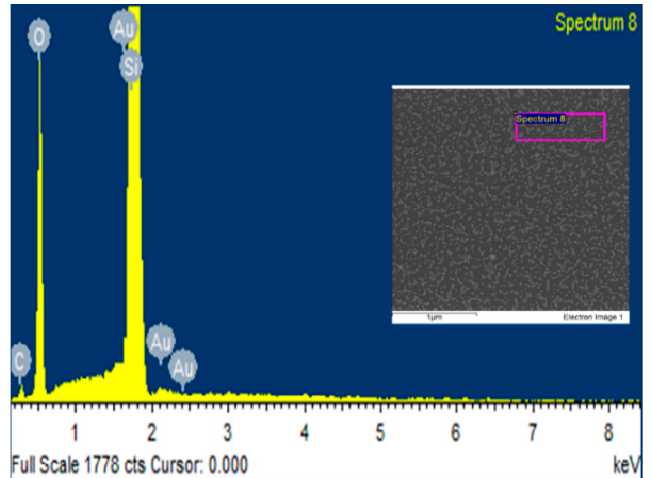
Figure 9. Elemental composition through EDS spectrum in the section determining the presence of elements.